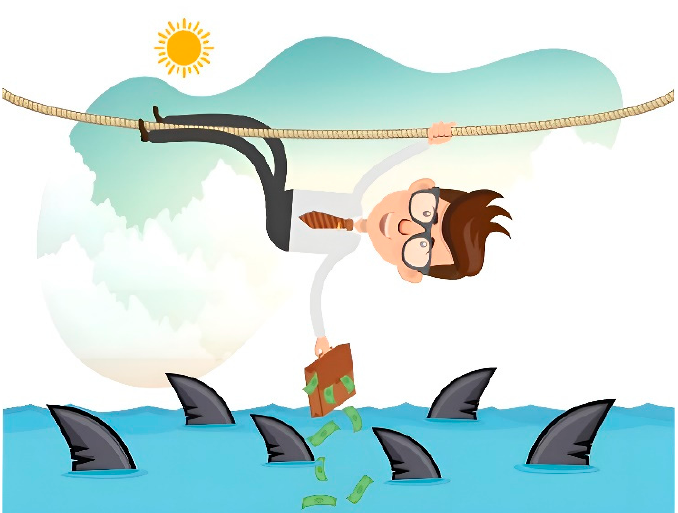
Figure 5. Visual metaphor of the “financial risk” concept. Source: www.capital.com Available online: https://bit.ly/3yETUvX (archived on 8 March 2023).